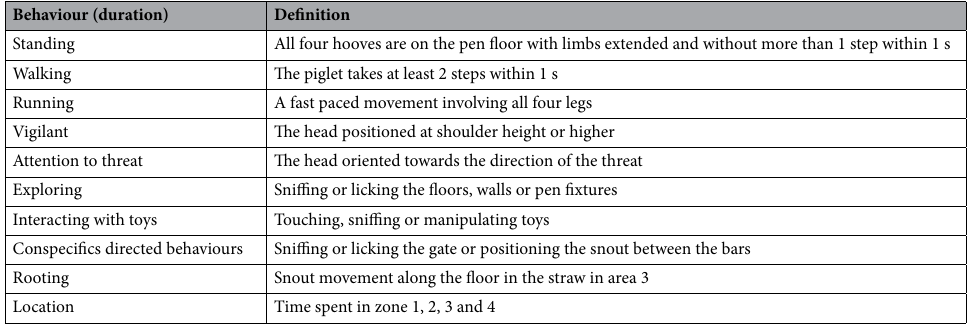
Table 3. Ethogram with behaviours scored during the attention bias